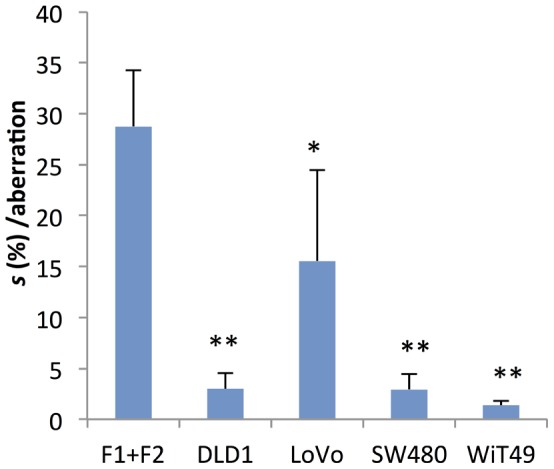
Negative selection acting on aneuploidy in cancer compared to normal cells.Mean aneusomy-dependent negative selection (s) estimated by Chiron-simulations. The single star denotes p<0.05 and double stars p<0.001 (Student’s t-test) at comparison between each cancer cell line and normal fibroblasts (F1+F2).